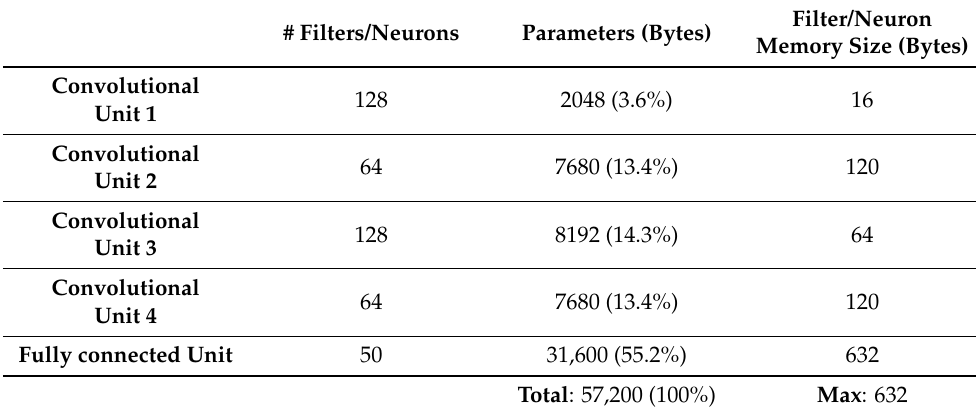
Table 7. ECG-ID-BNet memory usage per filter/neuron in each unit summary. #